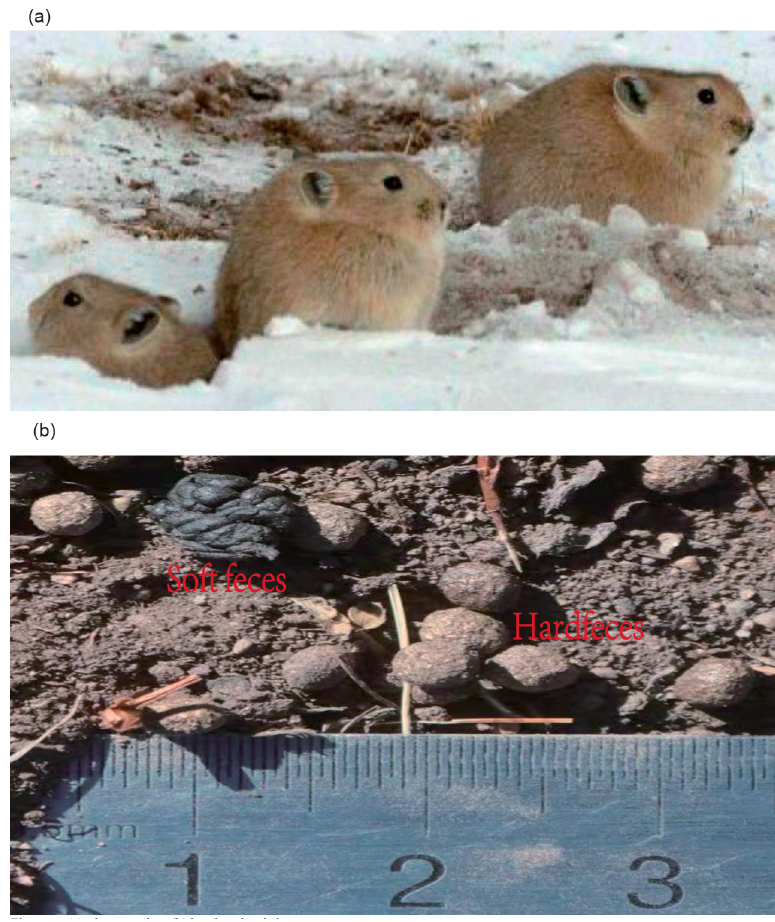
Figure 1. ( a ) plateau pikas ( b ) hard and soft feces The gut microbiome, which plays important roles in host energy harvesting, can be characterized using the fecal microbiome [27]. Although a previous study reported the influence of dietary factors on the microbiota of hard and soft feces in Lagomorpha [15], very little attention has been paid to the difference between fecal types based on the same